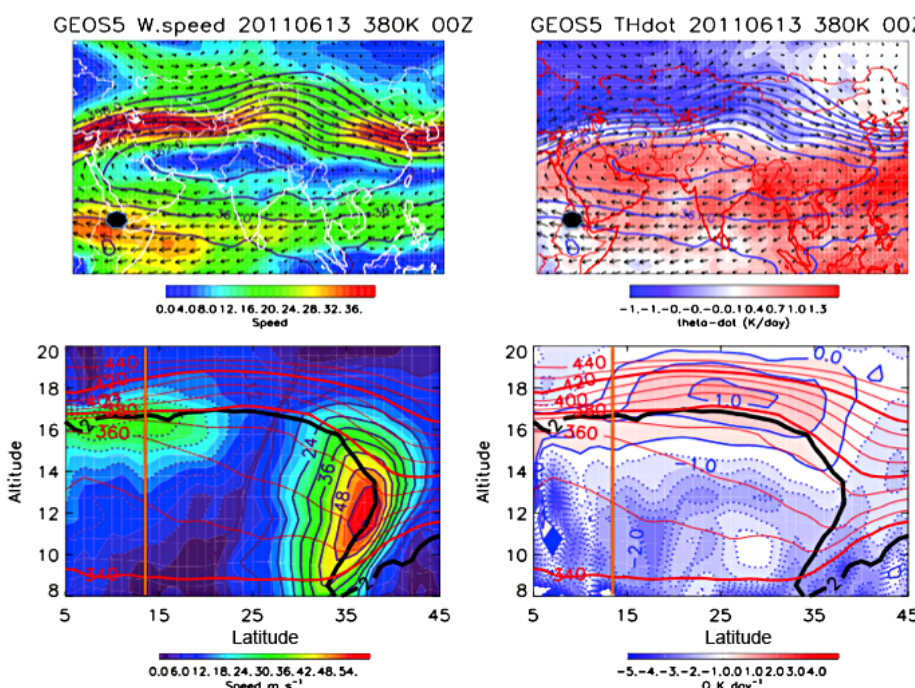
Figure 1. Top: maps of wind speed and diabatic heating rate at 380K potential temperature, θ , for 00:00Z, 13 June 2011. Isopleths of MSF, and wind vectors are also shown. A black spot marks the location of Mt. Nabro. Bottom: cross sections of wind speed and diabatic heating rate at 40 ◦ E for the same date and time. Isopleths of θ , PV = 2.0PVU, and vectors of the meridional wind component are also shown, an orange vertical line marks the latitude of Mt. Nabro. The resolution of the GEOS-5.2 data shown is 1.25 ◦ × 1 ◦ in the horizontal, ∼ 1km in the vertical for the altitudes